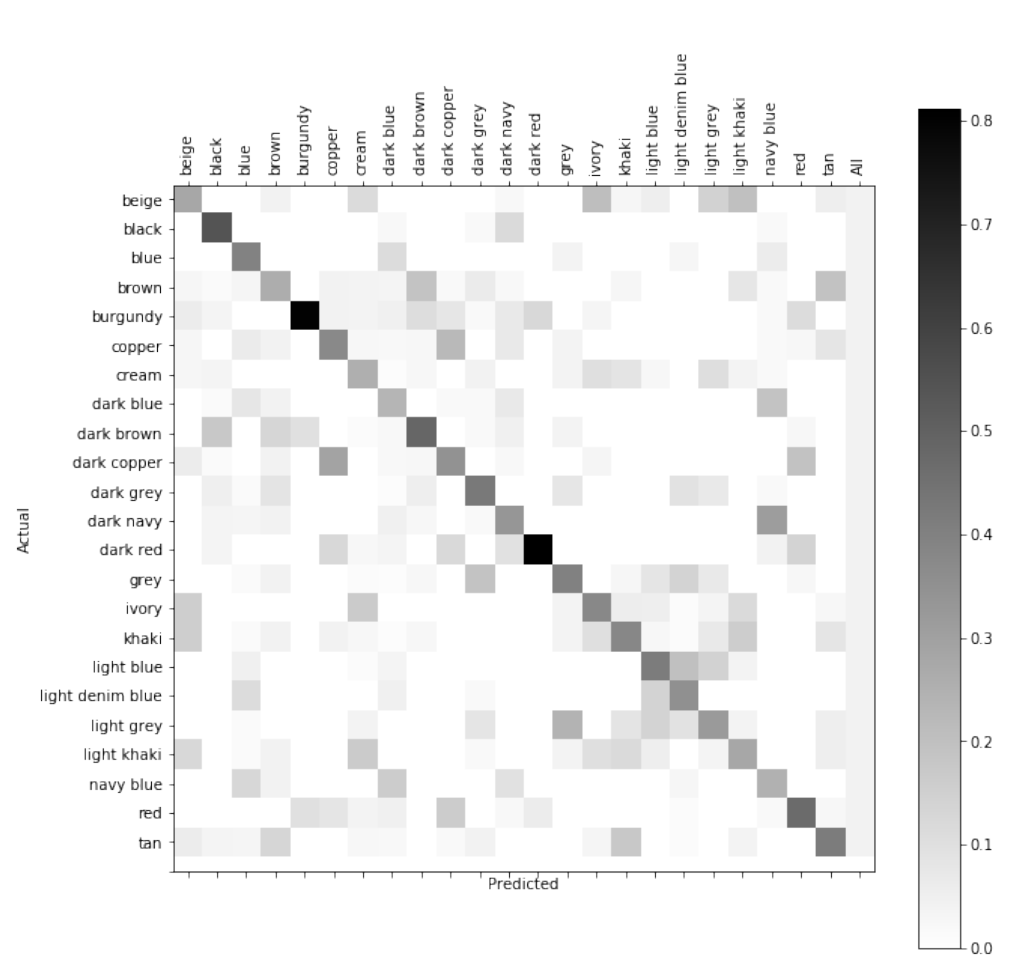
Figure 5. Color classification confusion